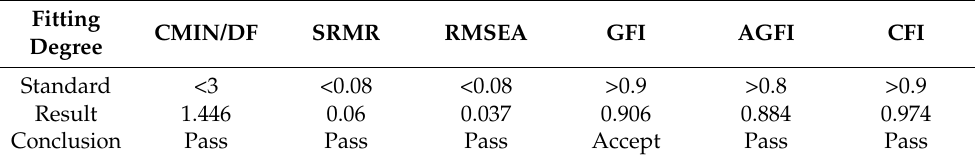
Table 3. The fitting degree of confirmatory factor analysis.